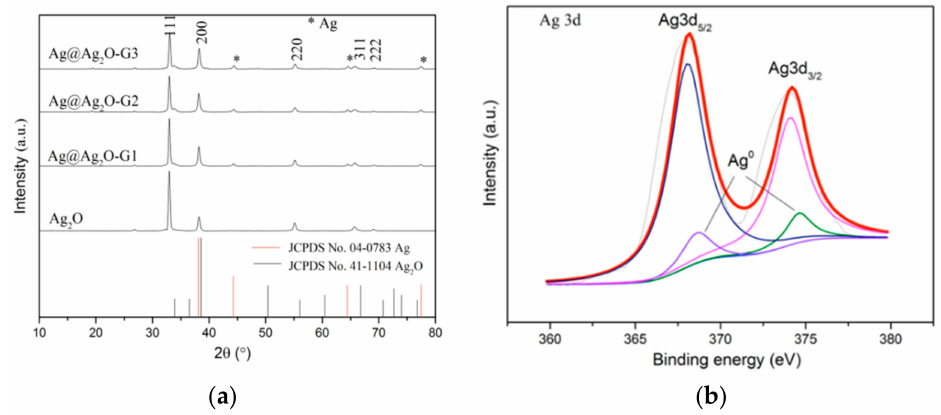
Figure 2. ( a ) XRD patternsof Ag 2 O, Ag@Ag 2 O-G1, Ag@Ag 2 O-G2, Ag@Ag 2 O-G3 and XPS peaks of ( b ) Ag 3d in Ag@Ag 2